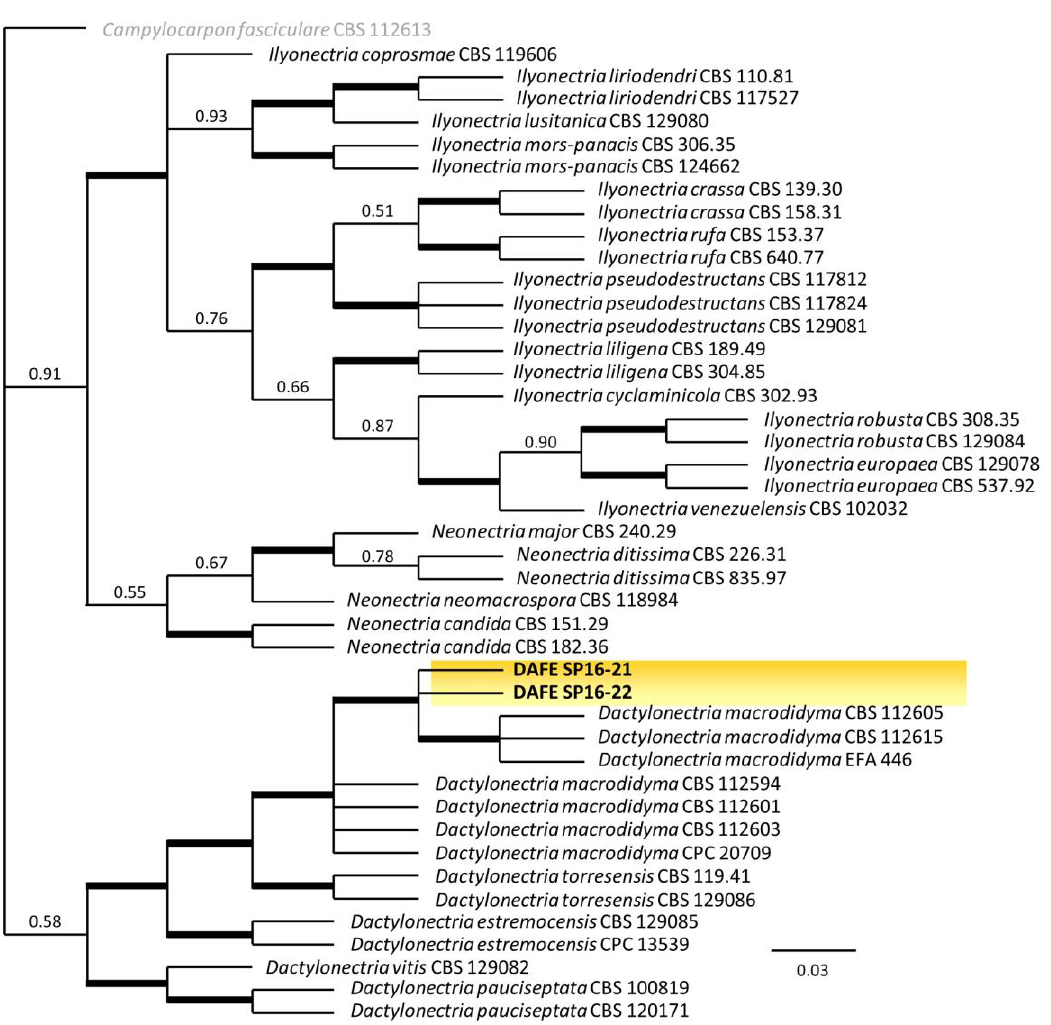
Figure 5. Bayesian inference phylogenetic tree generated using sequences of HIS3 . A GTR + G + I evolution model was used. The representative isolates DAFE SP16-21, and DAFE SP16-22 are highlighted in yellow. The values above branches show Bayesian Posterior Probability (BPP). Thicker branches represent nodes with BPP ≥ 0.95. The scale bar indicates the number of expected substitutions per site. Campylocarpon fasciculare (CBS 112613) was used as an outgroup.